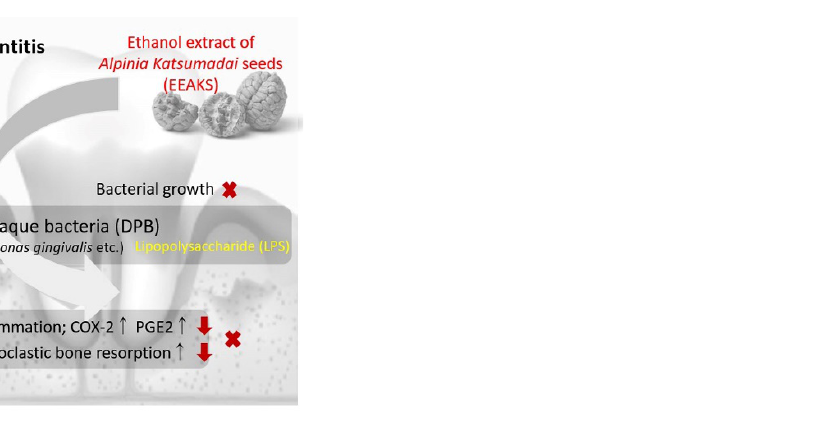
Figure 5. The proposed mechanism of ethanol extract of Alpinia Katsumadai seeds’ (EEAKSs’) anti- periodontitis